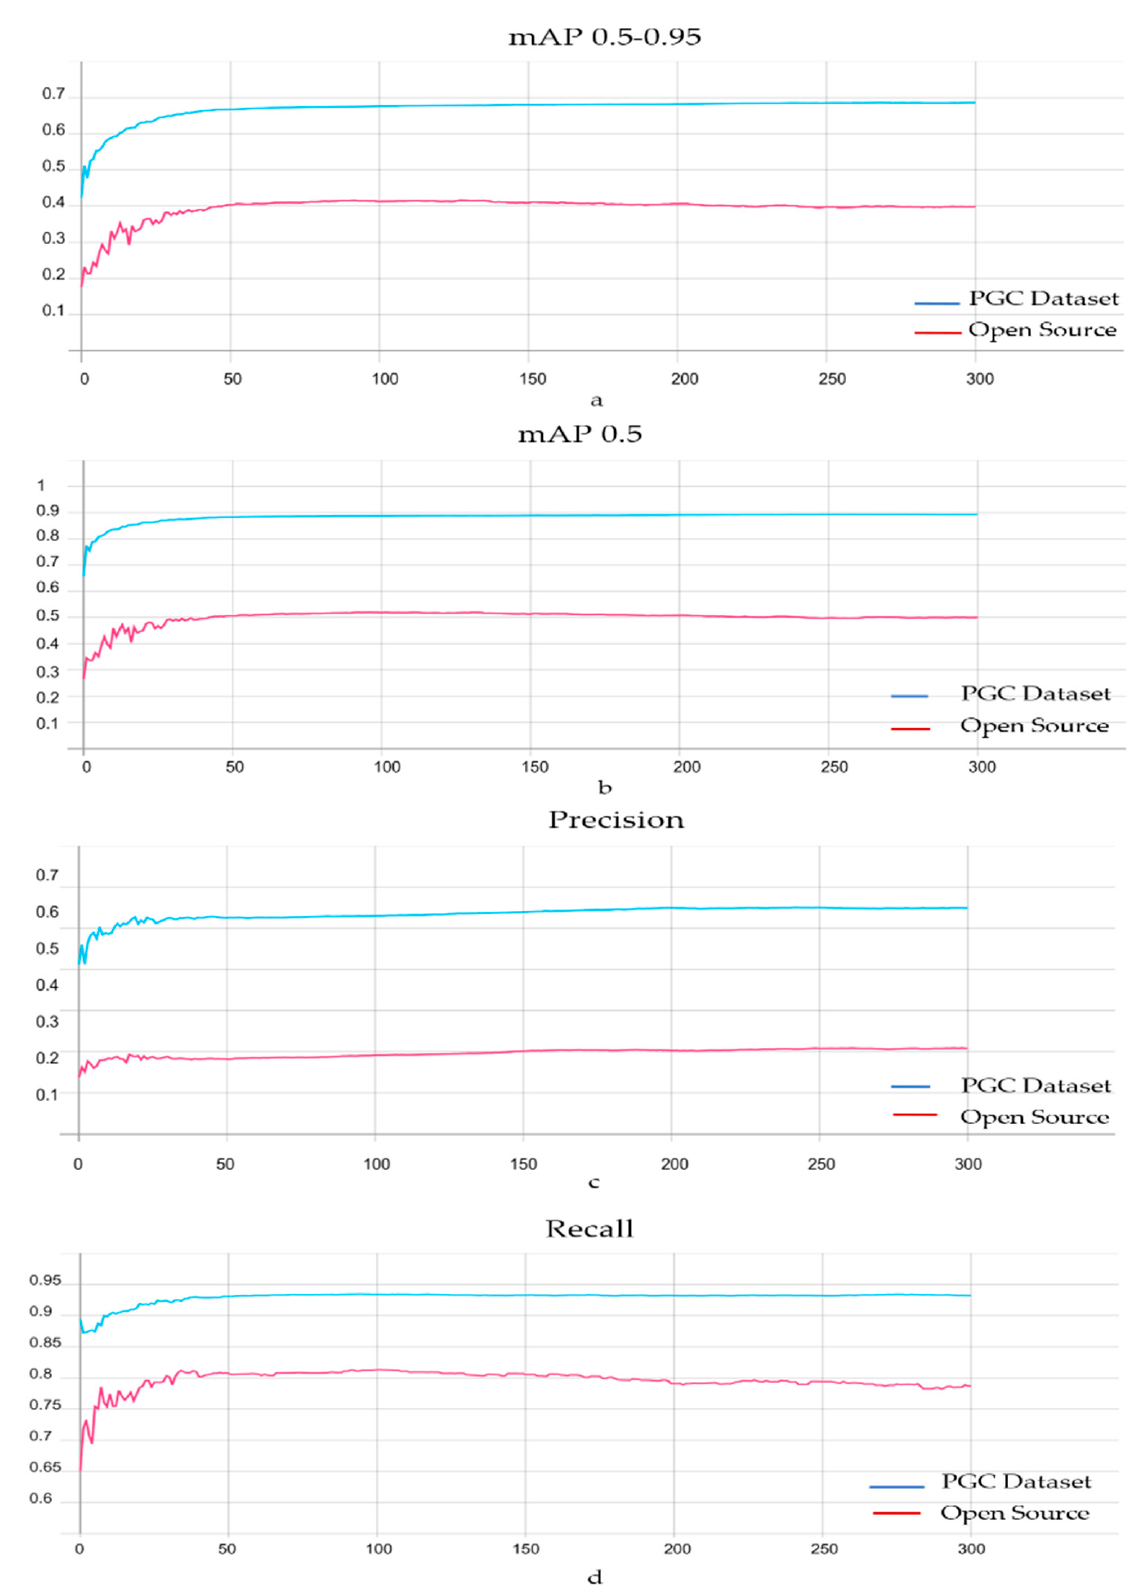
Figure 10. Four evaluation metrics, mAP 0.5–0.95 ( a ), mAP 0.5 ( b ), Recall ( c ), and Precision ( d ), that have been used to measure the performance of the PGC dataset and open dataset v6, after being used to train scaled YOLOv4. TensorBoard was used to create these graphics.